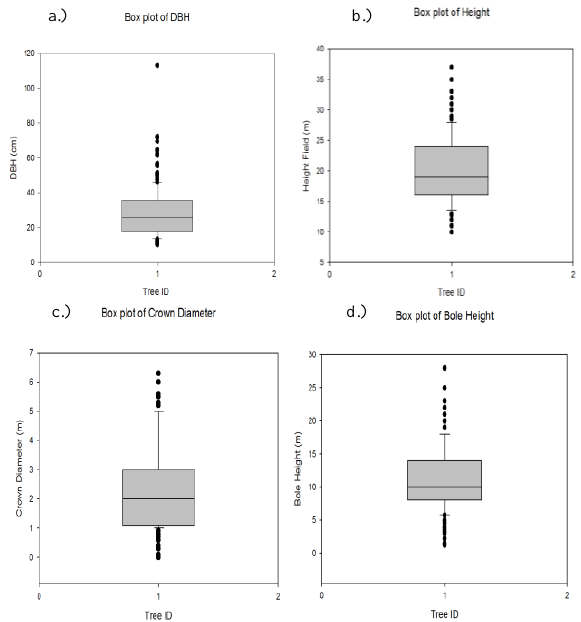
Figure 5. Box plot of data collection from field data